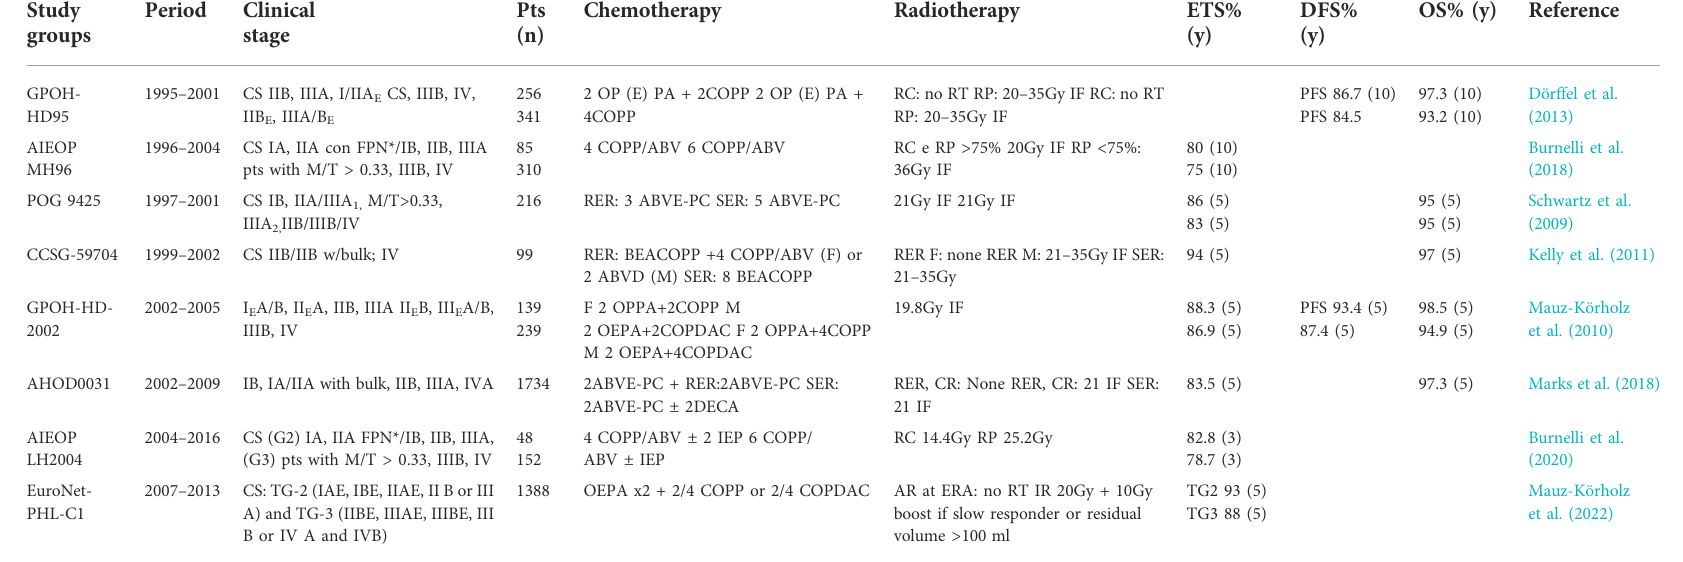
TABLE 3 Main clinical trials on pediatric patients with intermediate- and high-risk